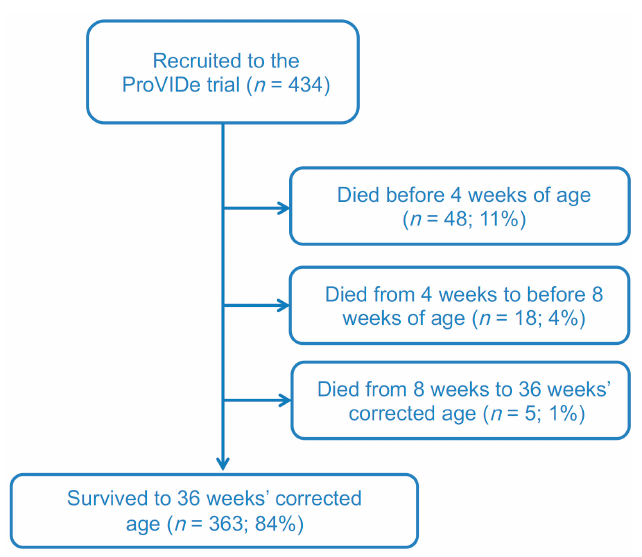
Figure 1. ProVIDe STROBE Flow Diagram.